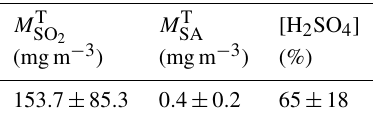
Table 1. Mean SO 2 and SA mass concentrations, and mean sulfuric acid mixing ratio in SA, for our retrieval session at Masaya volcano with associated standard deviations (due to their variability during the measurement session). These mean values are obtained by aver- aging 25 individual